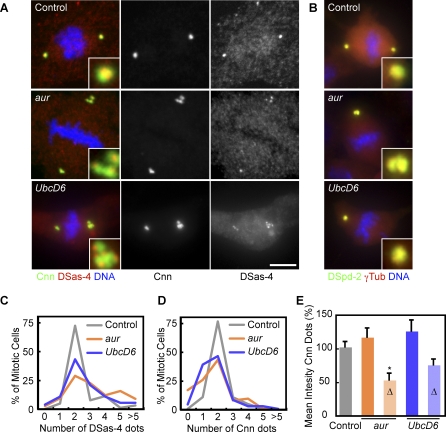
Genes Involved in Centrosome Separation (Class IV)(A) S2R+ cells treated with dsRNA against GFP (control), Aurora A (aur), and UbcD6 were stained with Hoechst (DNA, blue), DSas-4 (a centriole marker, red), and Cnn (a PCM marker, green). Inset shows a 4× magnified view.(B) Recruitment of DSpd-2 (green) and γ-tubulin (red) after dsRNA treatment for control, Aurora A, and UbcD6. DNA is shown in blue, and inset shows a 4× magnified view.(C and D) Analysis of centriole (C) and centrosome (D) numbers in mitotic cells after RNAi treatment. More than 30 mitotic cells were counted in two independent experiments.(E) Analysis of PCM size in mitotic cells after RNAi treatment. The graph represents the mean intensity of PCM staining (Cnn) from three independent experiments, each analysing more than 20 centrosomes. The lighter bars labelled with a Δ represent the PCM recruitment to the subset of the centrosomes that contained only one centriole dot. Error bars represent the SE. An asterisk (*) marks p ≤ 0.05 compared to control. This analysis suggests that PCM recruitment is impaired in cells depleted of Aurora A and UbcD6, but this effect is masked by the clustering of multiple centrosomes together.Scale bar in (A and B) represents 5 μm.